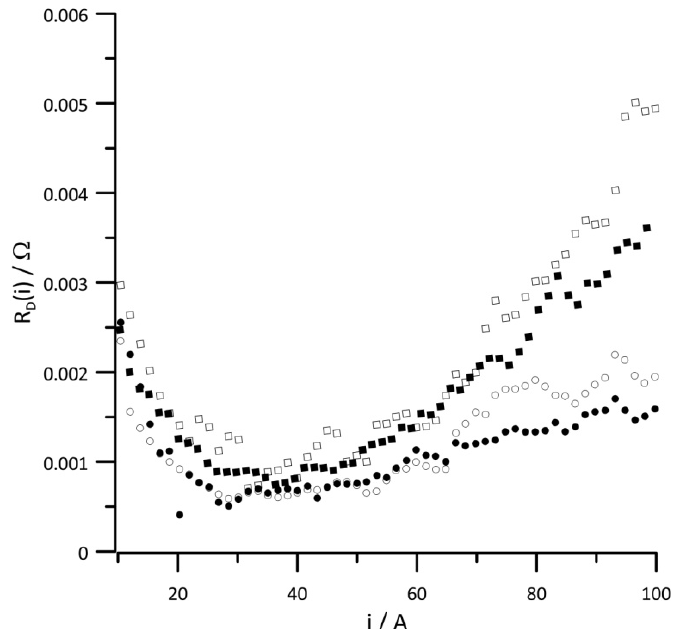
Figure 10. Instantaneous value of R D ( i ) versus current at reactant gas RH values of ( • ) 10%, ( ◦ ) 30%, ( ▪ ) 50%, and ( ▫ ) 80%. Geometric surface area S = 96 cm 2 , current load change rate d i /d t = 40 mA s − 1 .